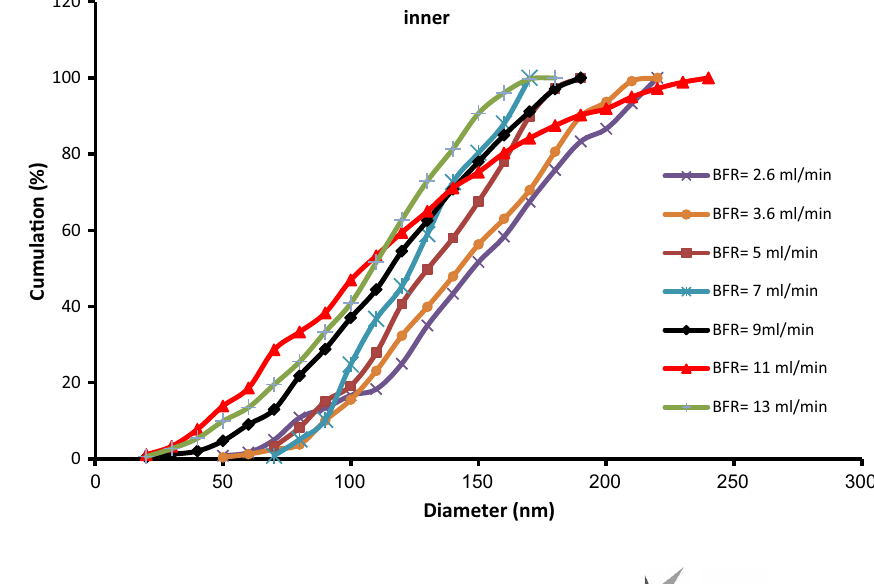
Fig. 7 Effect of ICFR on the mean pore size of the outer surface Fig. 8 Cumulative distribution of the pore size of the inner